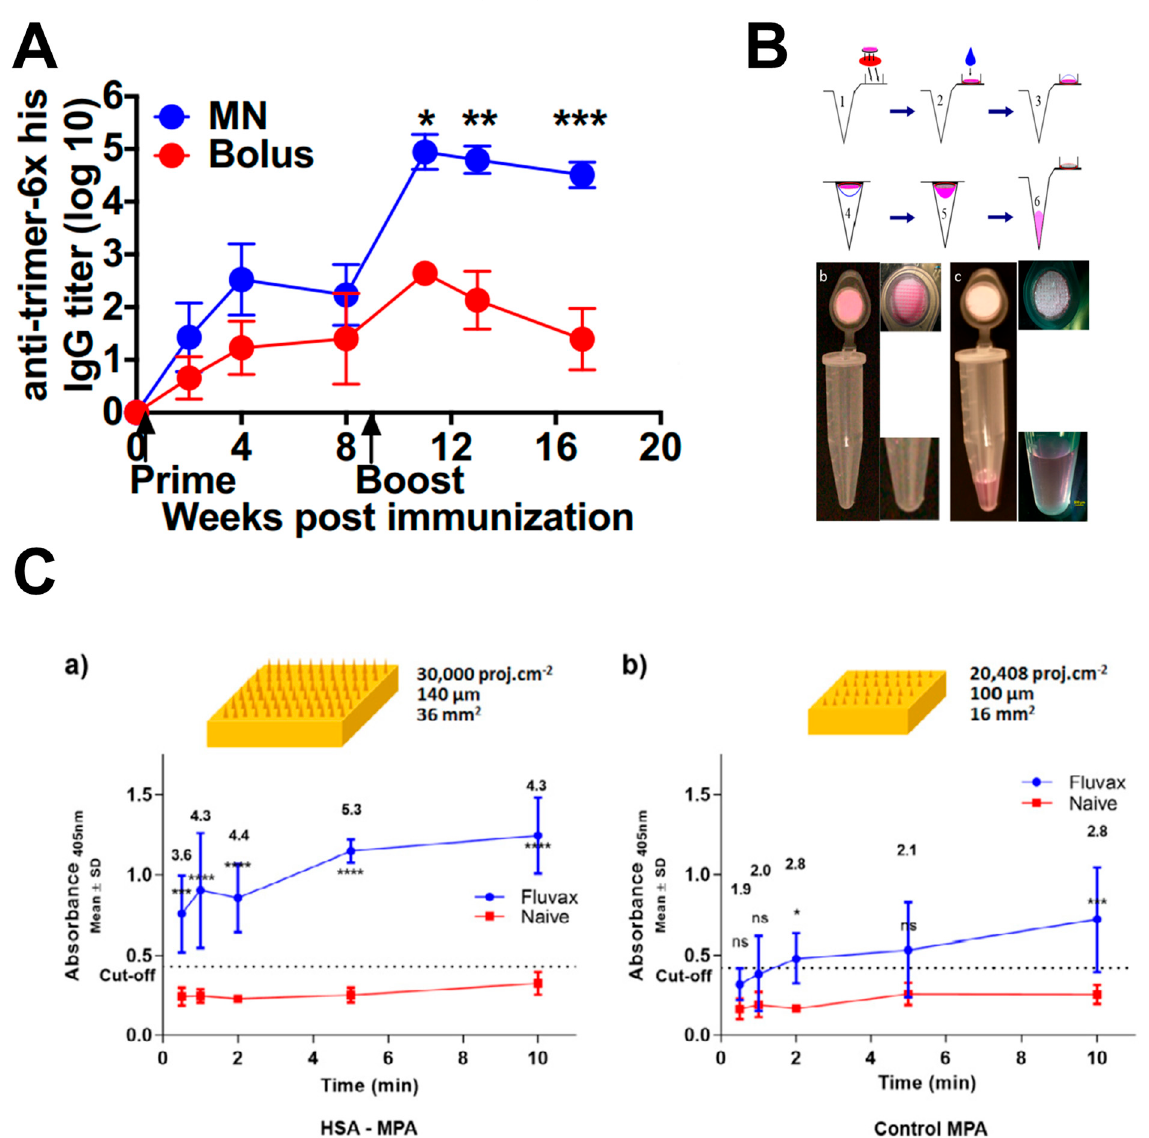
Figure 12. Analytical diagrams and schematics of microneedles used for vaccines and biosensors. ( A ) Enzyme-linked immunosorbent assay (ELISA) analyses of anti-trimer serum IgG responses over time in strong trimeric-specific humoral response maintained by MNs. ( B ) Procedures of microneedles to extract tissue fluid. ( C ) Fluvax IgG was captured from immunized mice to a certain extent by microneedles with different surface areas. In ( A , C ), 2-way ANOVA analysis is applied, and the significant difference is indicated by * p < 0.05, ** p < 0.01, *** p < 0.001, **** p < 0.0010, while n.s. indicates no significant difference. (Images were reproduced with permission from